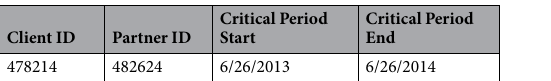
Table 2. The four fields of the data record considered in our analysis.